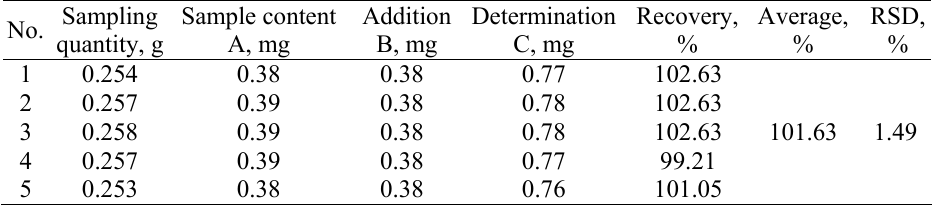
Table 2. Recovery rate of